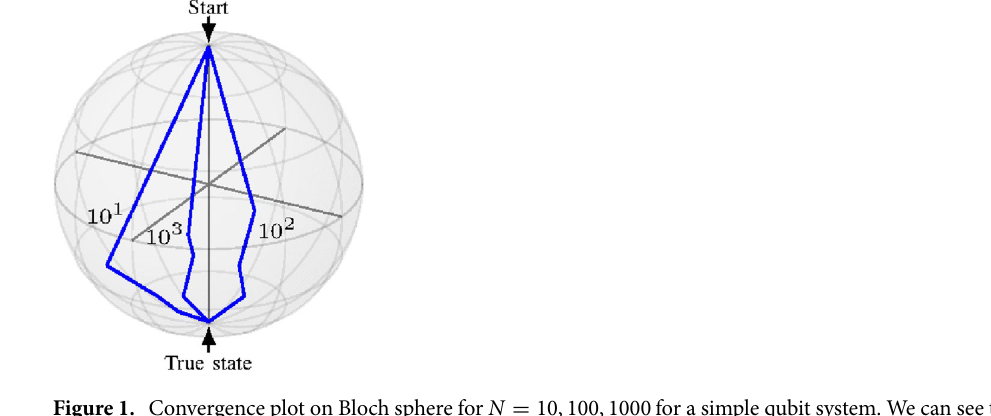
Figure 1. Convergence plot on Bloch sphere for N = 10, 100, 1000 for a simple qubit system. We can see that BB-SPSA converges faster with increase in number of measurements per